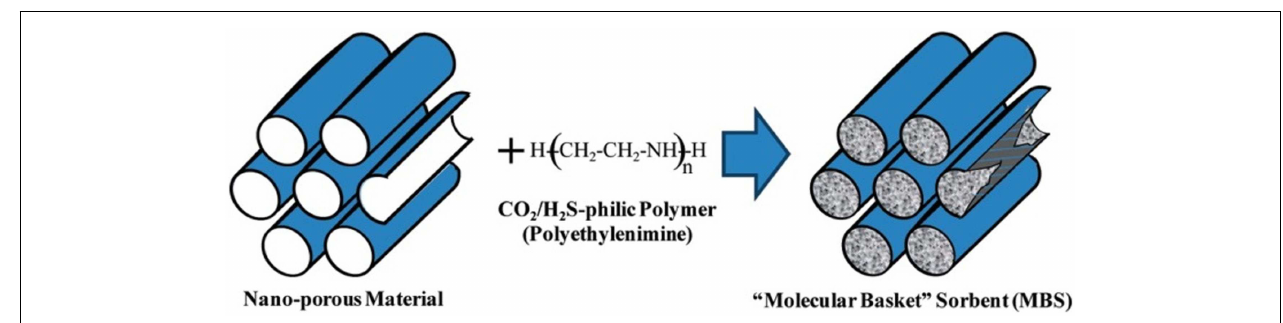
FIGURE 6 | Concept of “molecular basket,” reproduced from Ma et al. (2009)